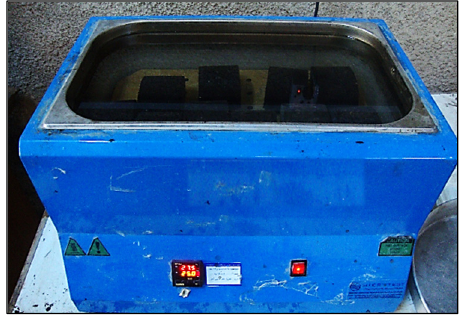
Figure 10. Soaking in the water bath.